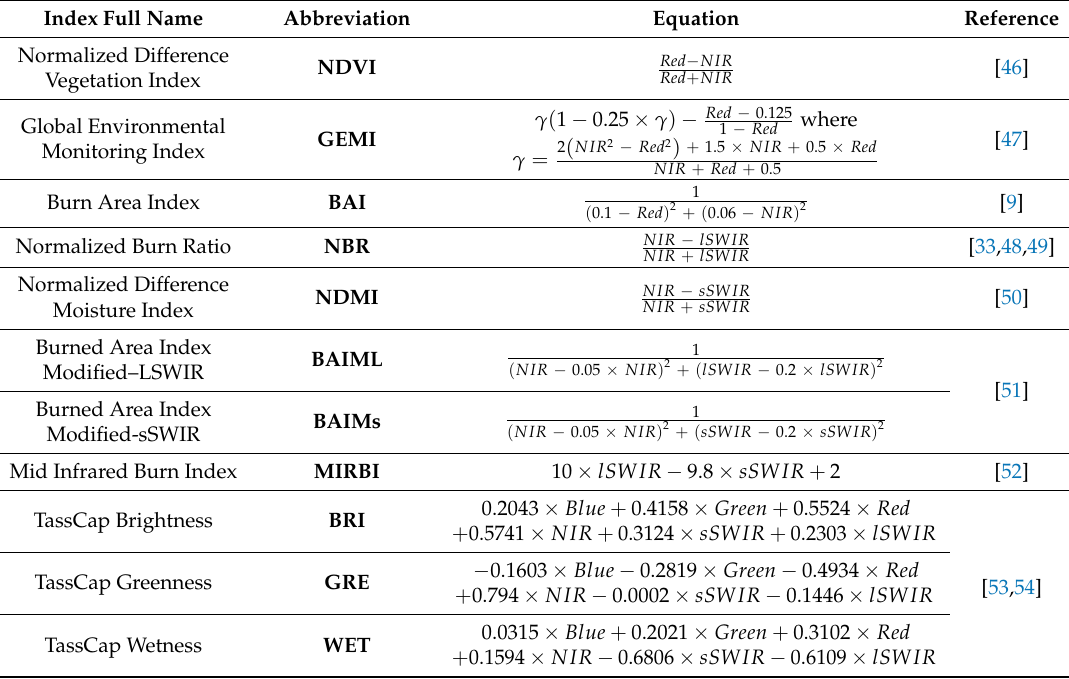
Table 2. List of spectral indices and image transformation techniques. Blue = visible blue Landsat Thematic Mapper (TM) band 1; Green = visible green Landsat TM band 2; Red = visible red Landsat TM band 3; NIR = near infrared Landsat TM band 4; sSWIR = shorter shortwave infrared Landsat TM band 5; lSWIR = longer shortwave infrared Landsat TM band